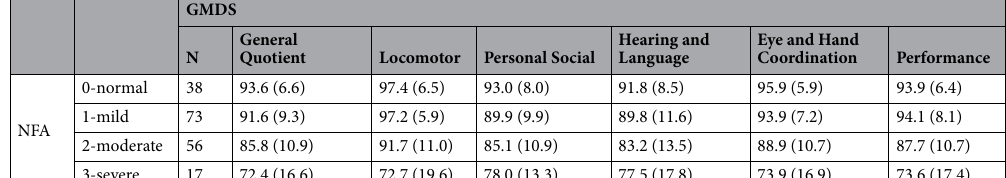
GMDS General N Quotient Locomotor Personal Social